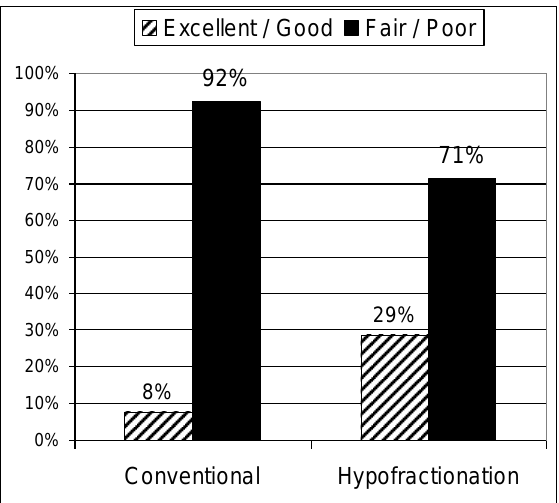
Figure 2: Patients’ cosmetic rating two years after finishing radiotherapy